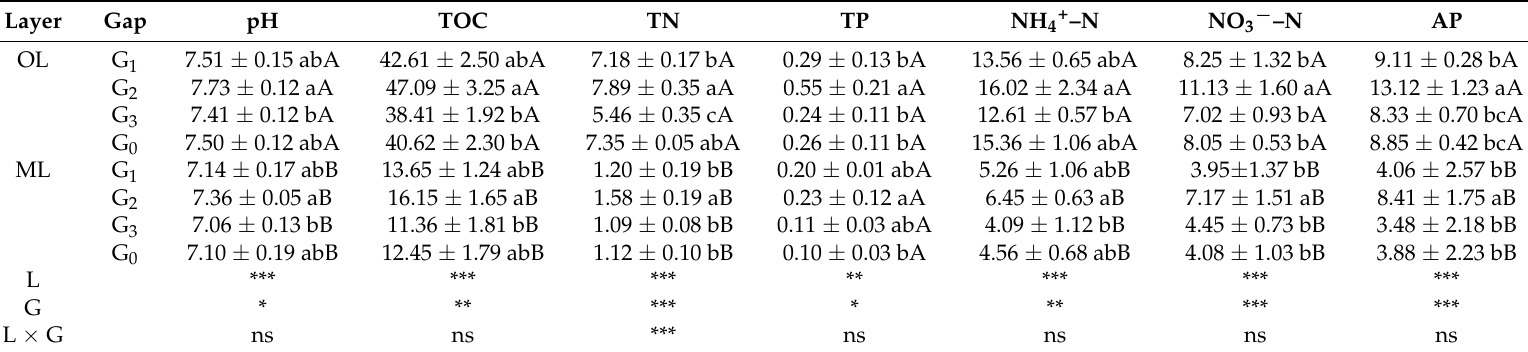
Table 2. Soil chemical properties in the organic and mineral soils from four treatments. Values are the mean ± standard deviation (n = 3). Layer